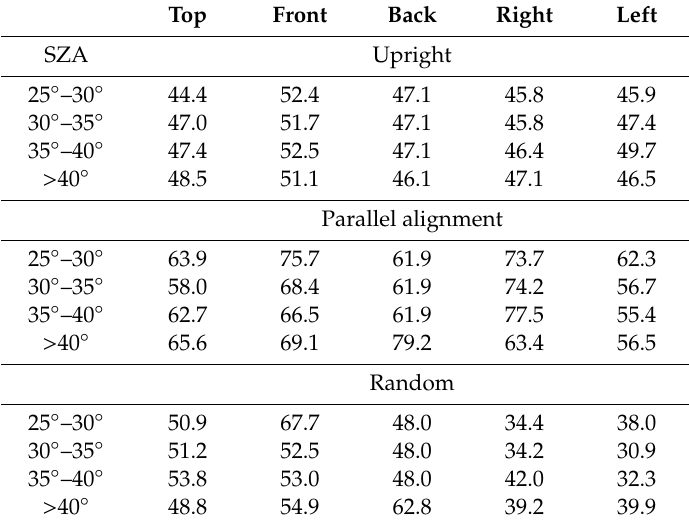
Table 3. PPFs (%) for di ff erent Solar Zenith Angles (SZAs). PPF: predictive protection factor. Top Front Back Right Left SZA